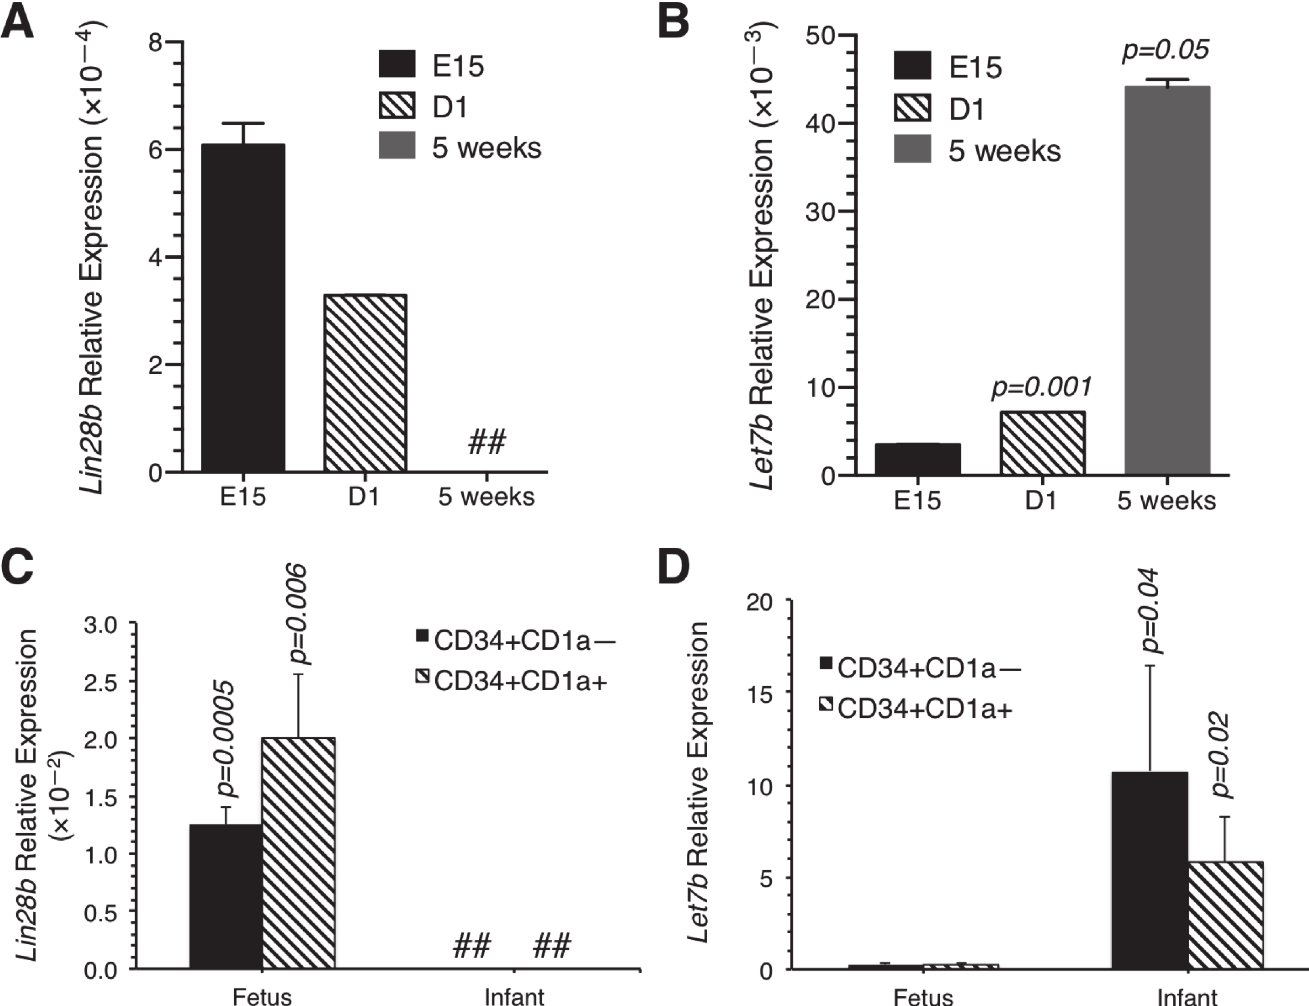
Fig 4. Expression of Lin28b and let7b in murine and human thymic progenitors. (A) Expression of Lin28b relative to Gapdh in ETP from E15 embryos (E15), day 1 neonates (D1), and 5 week old (5 weeks) mice by qPCR. Lin28b expression was undetectable in ETP from 5 week old mice. Data shown represent means ± SD. (B) Expression of Let7b relative to Sno202 in ETP, DN2, DN3 and DN4 progenitors from E15, D1, and 5 week old B6 mice. Levels of let7b are significantly higher in ETP from D1 and 5 week old mice compared to cells from E15 embryos. Data shown represent means ± SD. In A and B, wild type thymii from 6 – 10 fetuses and 6 – 8 day 1 neonates were pooled and ETP isolated. The 5 week old mice (4 – 6 animals) were processed individually. qPCR reactions were run twice. (C) Expression of Lin28b in human Lin - CD34 + CD1a - and Lin - CD34 + CD1a + T cell progenitors. Expression was higher in the fetal progenitors. (D) Expression of let7b relative to Sno202 in human Lin - CD34 + CD1a - and Lin - CD34 + CDa1 + T cell progenitors. Expression was significantly higher in the infant compared to fetal progenitors. ##; not detected. p values are indicated on the figure.